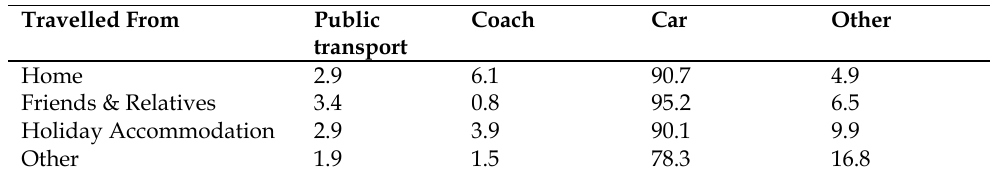
Table 5. Main Methods of Transport to the NT Property by where respondents travelled from (%) Travelled From